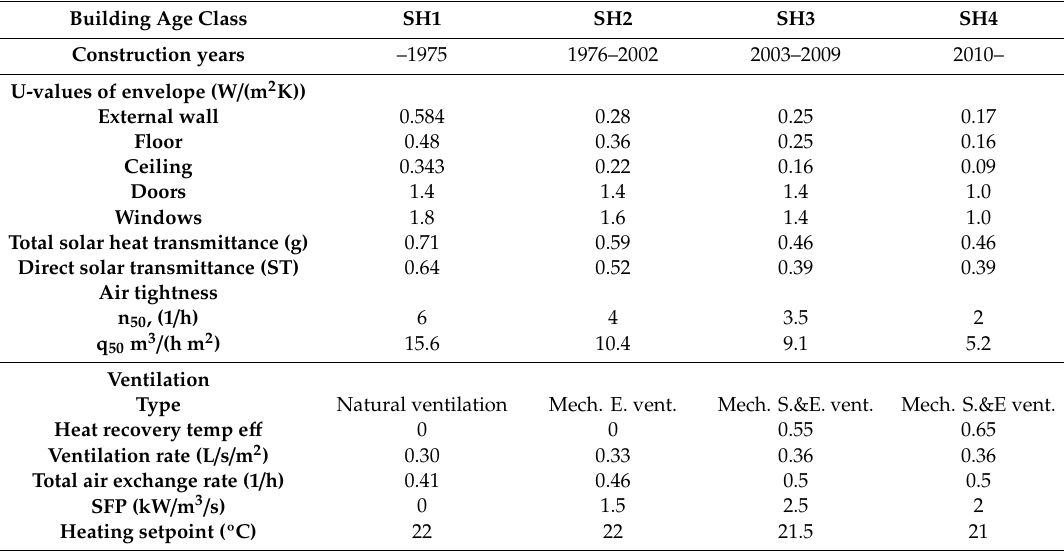
Figure 2. Distribution of built floor area in single-family houses over different construction periods. Table 1. Properties of the reference single-family houses [37].